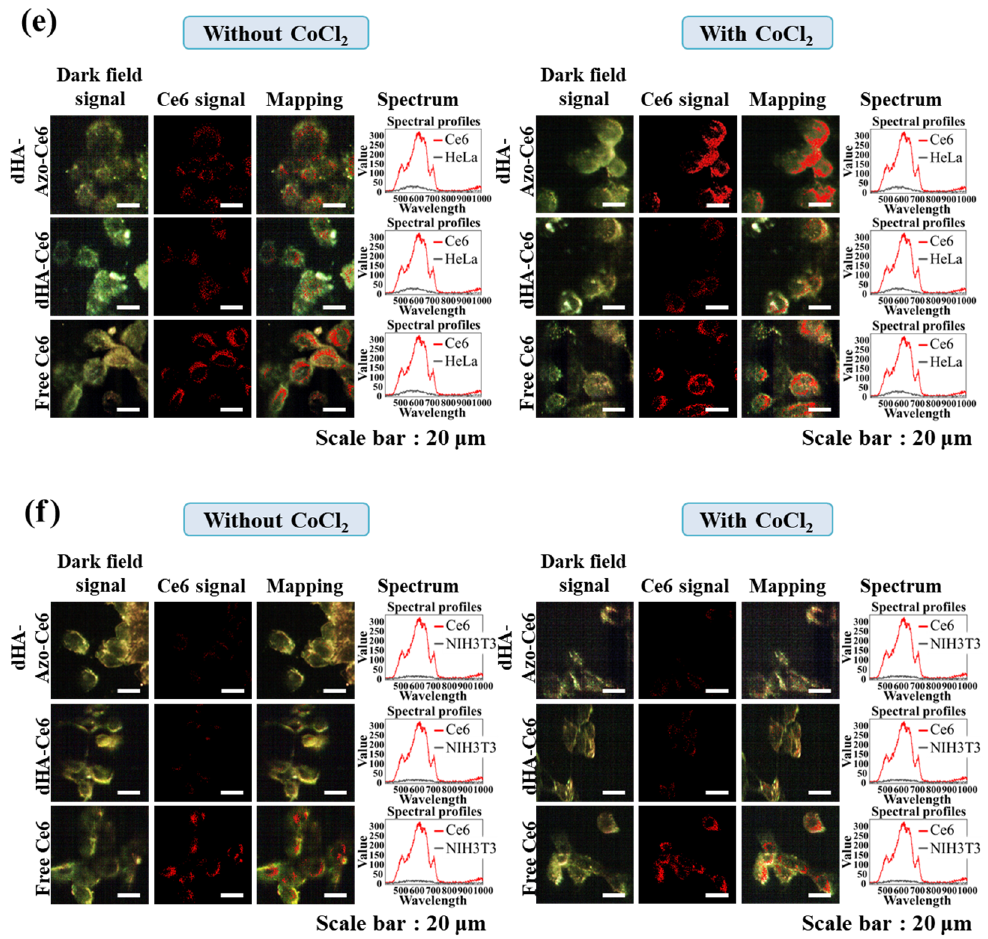
Figure 5. Flow cytometry analysis of ( a ) HeLa and ( b ) NIH3T3 cells treated with each sample (equivalent Ce6 10 μ g/mL) or free Ce6 (10 μ g/mL) under environment with CoCl 2 or without CoCl 2 for 2 h at 37 °C. Confocal images of ( c ) HeLa and ( d ) NIH3T3 cells treated with each sample (equivalent Ce6 10 μ g/mL) or free Ce6 (10 μ g/mL) under environment with CoCl 2 or without CoCl 2 for 2 h at 37 °C. Hyperspectral images of ( e ) HeLa and ( f ) NIH3T3 cells treated with each sample (equivalent Ce6 10 μ g/mL) or free Ce6 (10 μ g/mL) under environment with CoCl 2 or without CoCl 2 for 2 h at 37 °C.